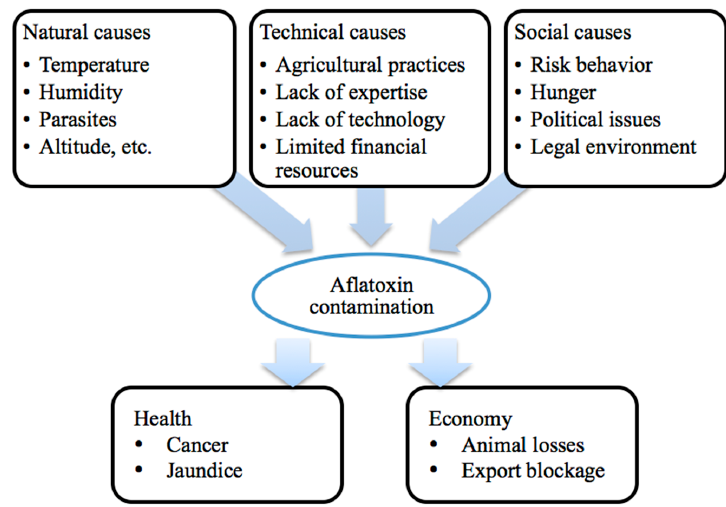
Figure 1. Causes and impact of aflatoxin contamination.